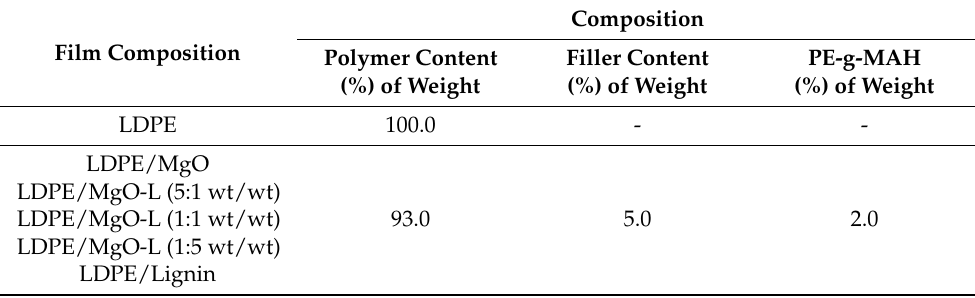
Figure 1. The apparent transparency cutaway foil strips of extruded samples: ( a ) pristine LDPE, ( b ) LDPE/MgO, ( c ) LDPE/MgO-L (5:1 wt/wt), ( d ) LDPE/MgO-L (1:1 wt/wt), ( e ) LDPE/MgO-L (1:5 wt/wt), and ( f ) LDPE/Lignin. Table 1. Percentage contributions of MgO-lignin (MgO-L) bio-filler into LDPE matrix in films extruded with a chill roll speed of 2 m/min.